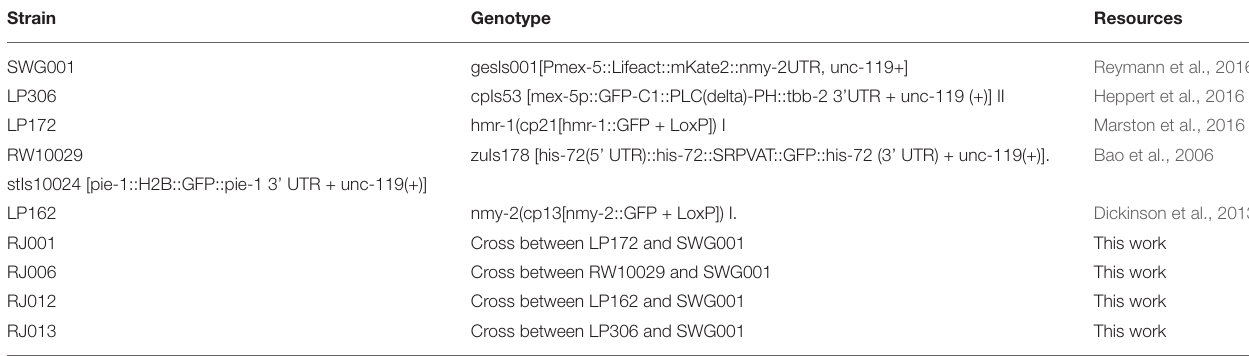
TABLE 1 | C. elegans strains used in this work. Strain